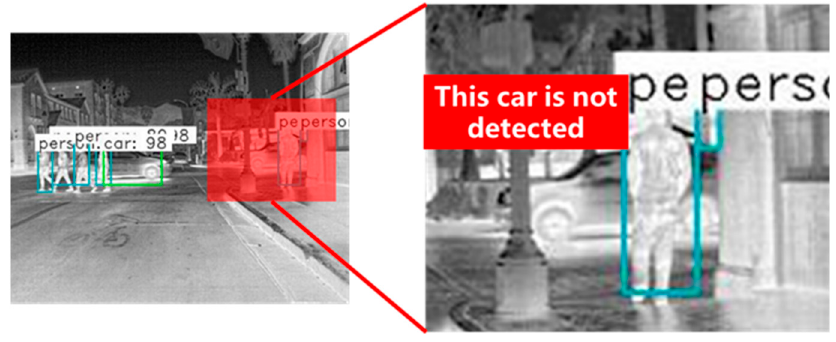
Figure 4. CMF Net target detection results.